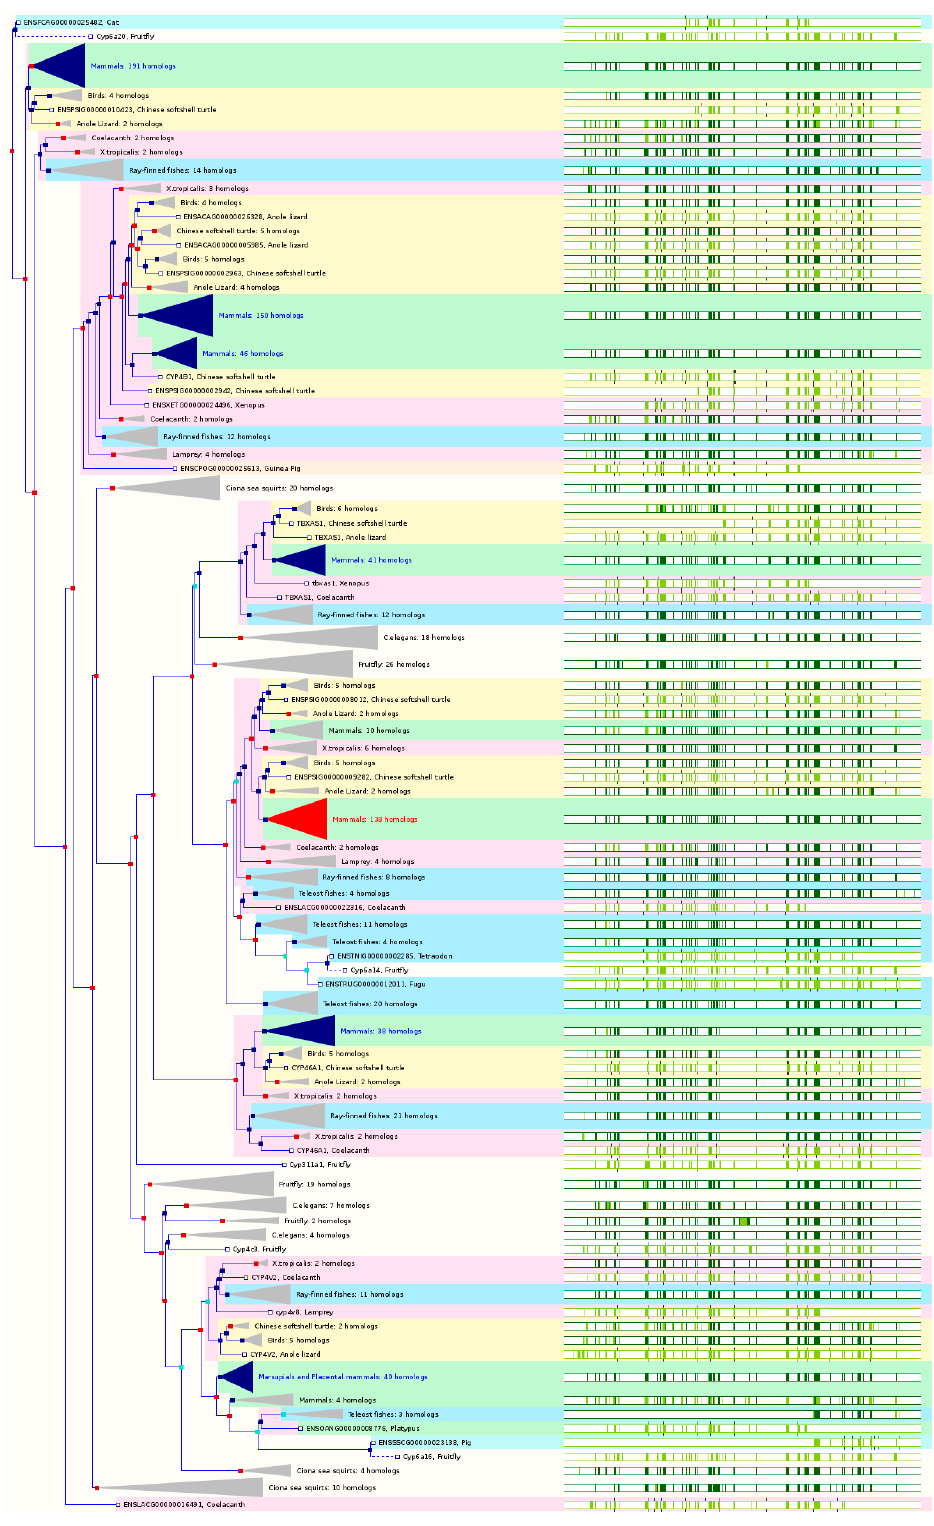
Figure 4. Cont. Figure 4.